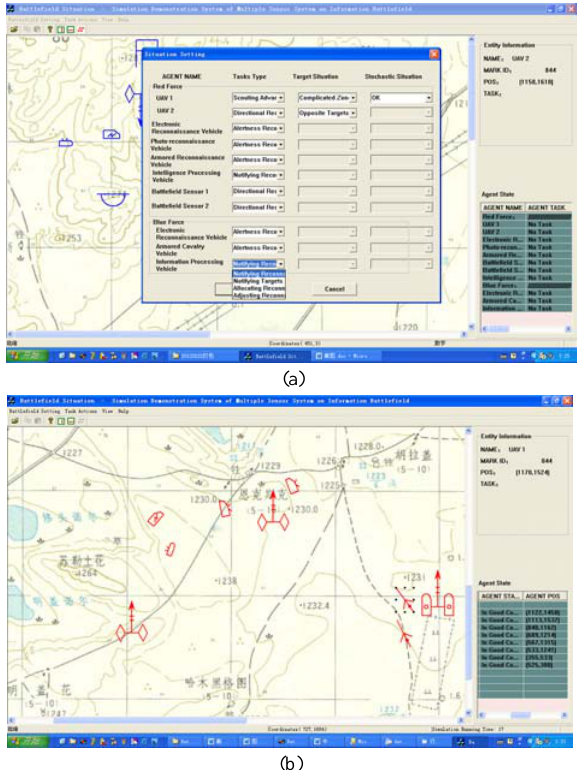
Fig.13. Simulation demonstration